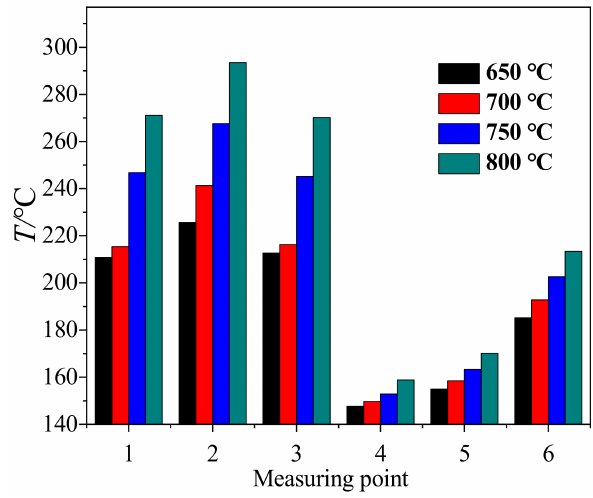
Figure 7. Effects of exhaust temperature on the